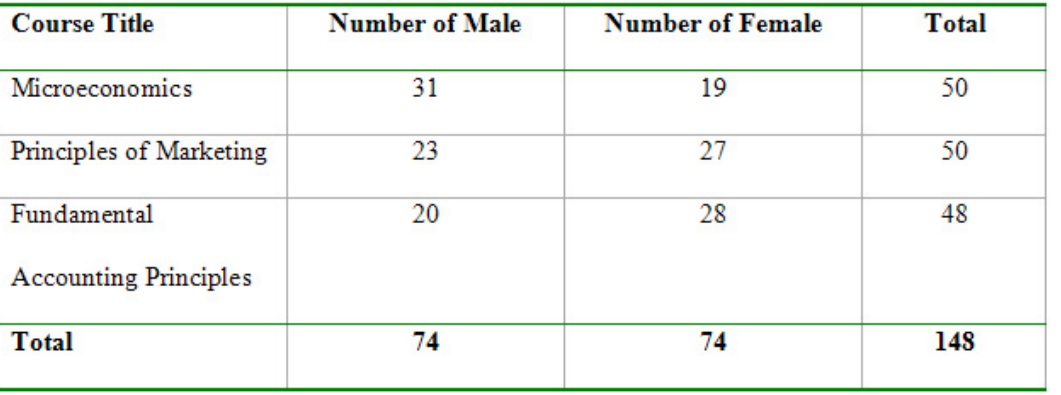
Table 1. First Round Scholarship Distribution by Course and